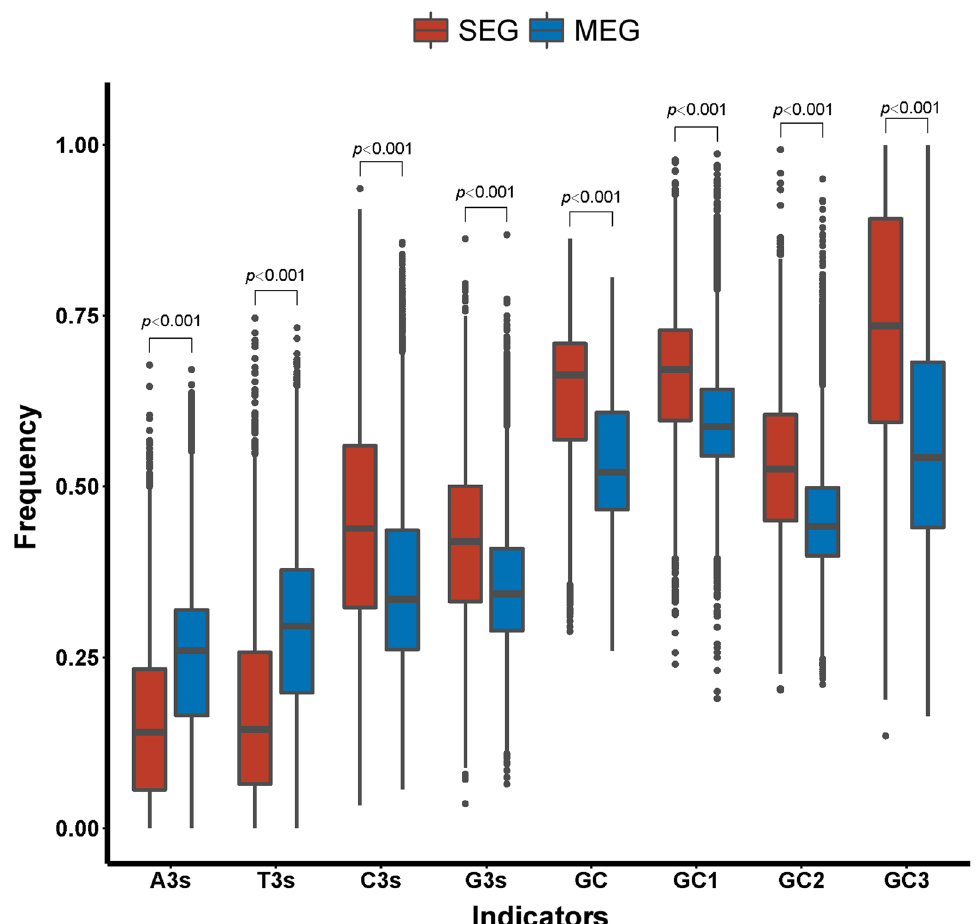
Fig. 2 Comparison of base composition of coding sequences of single-exon genes and multiple-exon genes in rice. Here, A3s, T3s, C3s, or G3s is the frequency that codons have an A, T, C, or G at their synonymous third position, relative to the amino acids that could have a synonym with A, T, C, or G in the synonymous third codon position. GC1, GC2, or GC3 is the percentage of GC content at the first, second, and third codon position,